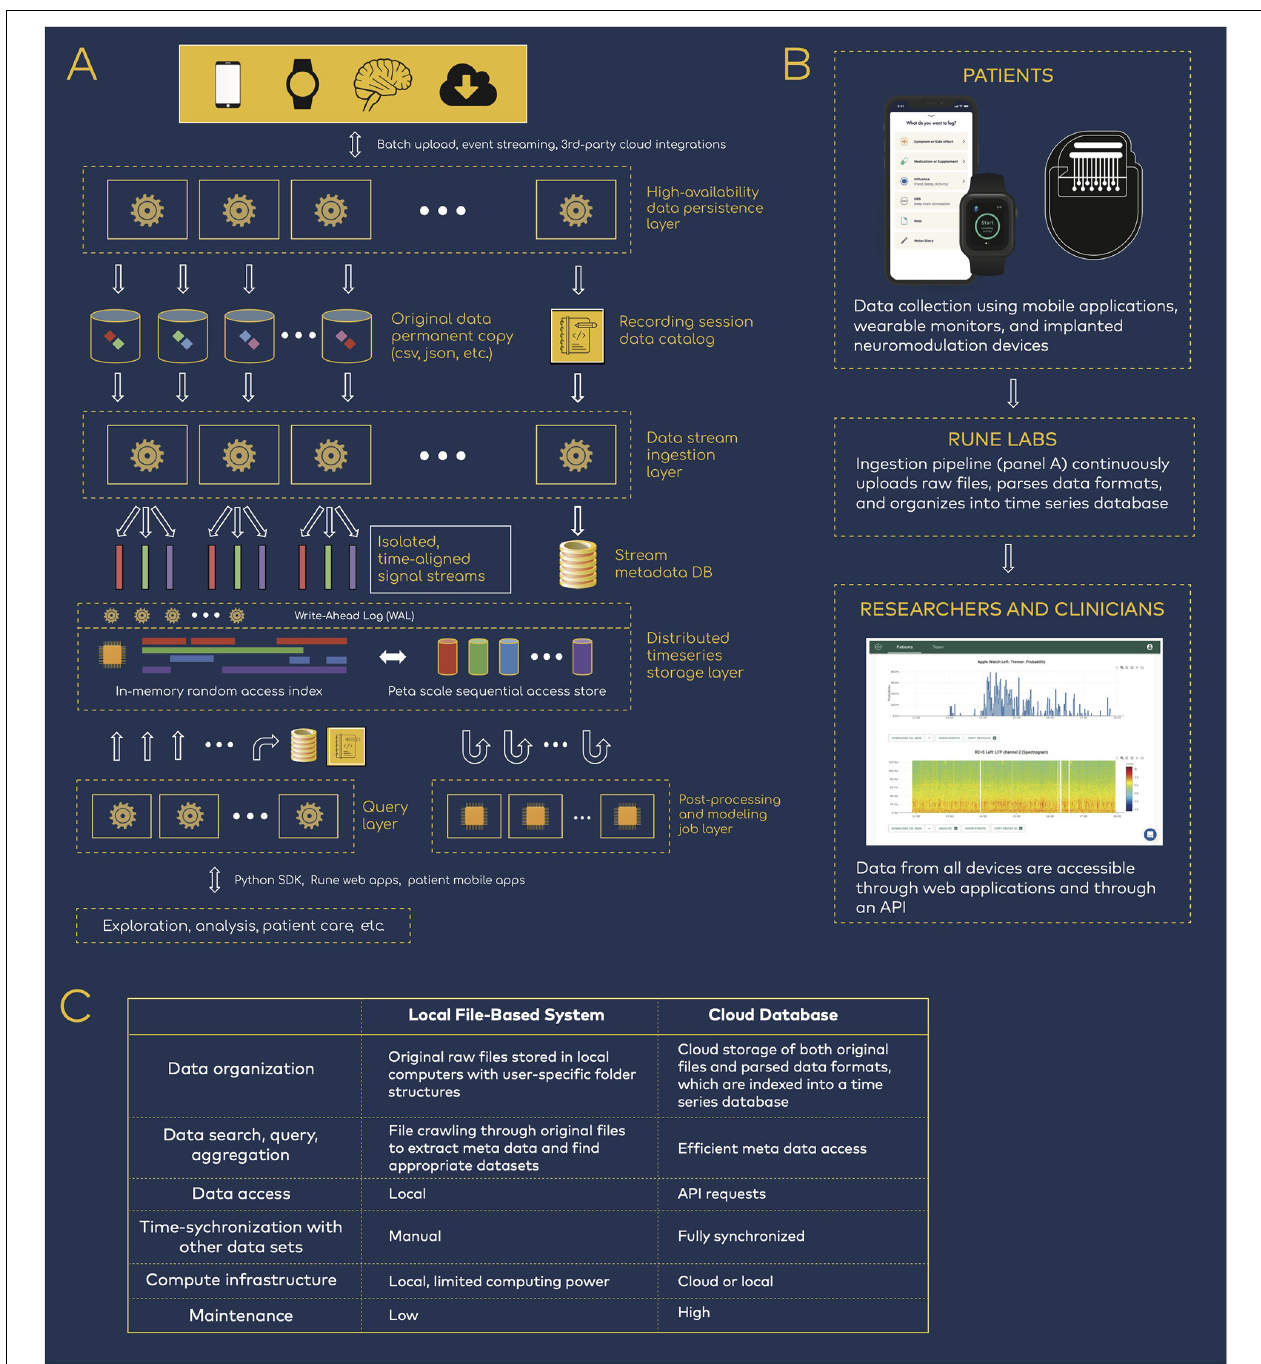
FIGURE 1 | Data infrastructure for neuromodulation research. (A) Rune system architecture. Patient data spanning neural physiology, wearable physiology, and mobile applications step through several processing layers that parse, synchronize, and store the multi-modal data streams. (B) Data flow from patients to researchers and clinicians. The data infrastructure pipeline is integrated into research workflows, such that researchers have easy access to patient data but are removed from the process of managing the data transition and ingestion. (C) Comparison of local versus cloud-based data management.